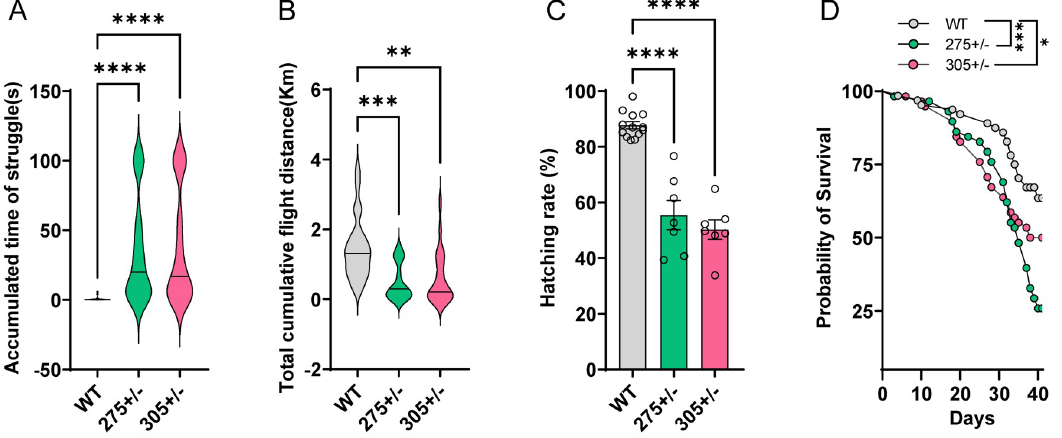
Fig 4. miR-275 and miR-305 maternal loss-of-function mutants exhibited impaired flight capability, decreased hatching rate and survival rate. (A) Negative flip duration of heterozygous mutants and wild-type flies. (B) Effect of miRNA mutation on the cumulative flight distance. The flight mill system was used to compute the flight performance of heterozygote mutant and wild-type females at 10 DPE. (C) Embryo hatchability of the heterozygous mutants and wild-type flies. Flies with depleted miR-275 and miR- 305 showed only 55.48% and 50.28% mean hatching rates, whereas wild-type flies showed an 87.74% mean hatching rate. Each treatment contained 200 eggs and 8 biological replicates. (D) Survival curves of heterozygous mutant and wild-type adult female flies. The survival rate was monitored for 40 days after genotype identification. Survival curves indicated that the survival rate of miR-275 +/- and miR-305 +/- was significantly lower than wild-type flies ( P = 0.0002 and P = 0.037, respectively, n = 60, Gehan- Breslow-Wilcoxon test). The data are expressed as mean ± SEM. ��� , P <